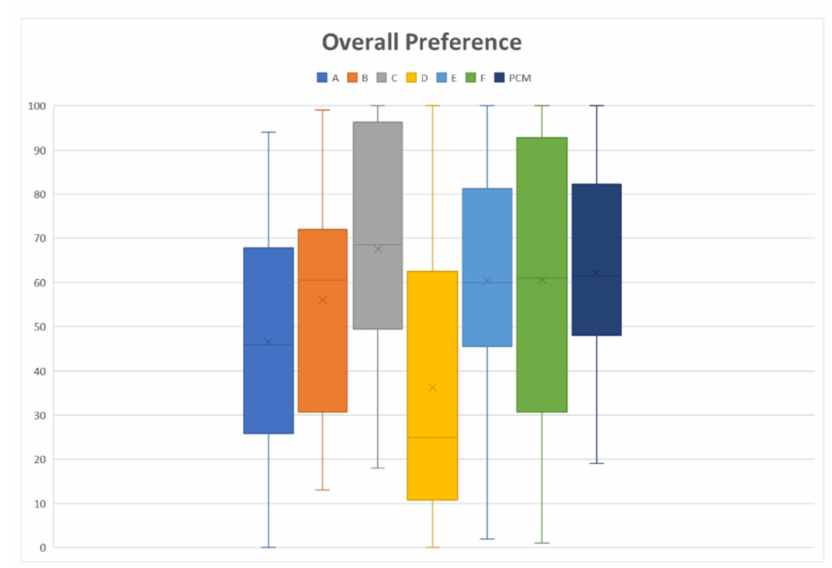
Figure 5. Overall preference toward fluid gel formulation, where 0 is “Extremely like” and 100 is “Extremely dislike”. Paracetamol (PCM) acts as a control, which is a perception when taking marketed paracetamol suspension/syrup. Fluid gels formulated with different consistency were assigned as samples A and D (thin liquid), B and E (mildly thickened liquid), and C and F (highly thickened